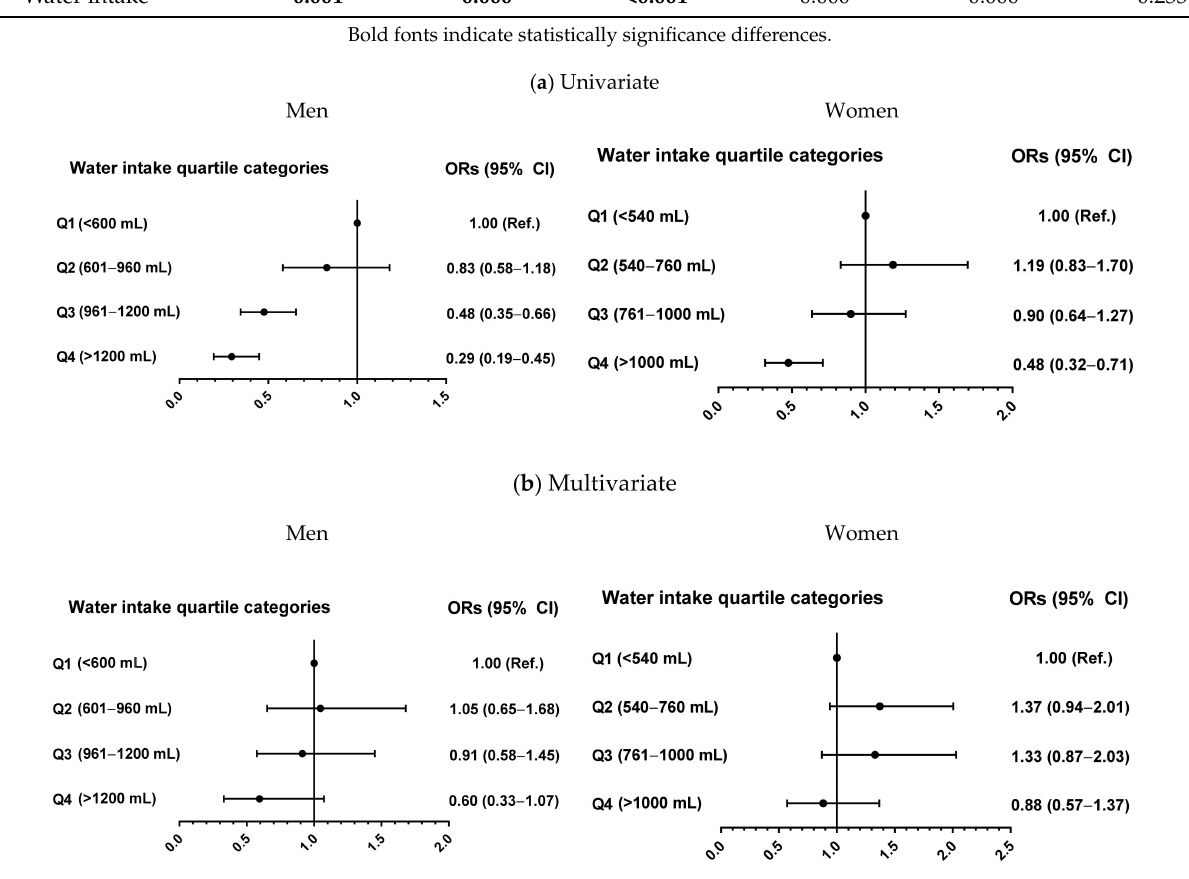
Figure 2. Odds ratios (95% confidence intervals) for low muscle strength depending on water intake quartiles before ( a ) and after ( b ) adjustment for confounding variables in men and women by logistic regression analyses. Confounding factors included age, body mass index, resistance exercise, smoking status, heavy alcohol drinking, protein intake, and total energy intake. The cutoffs for hand grip strength defining low muscle strength were 28.6 kg in men and 16.4 kg in women. Abbreviations: ORs, odds